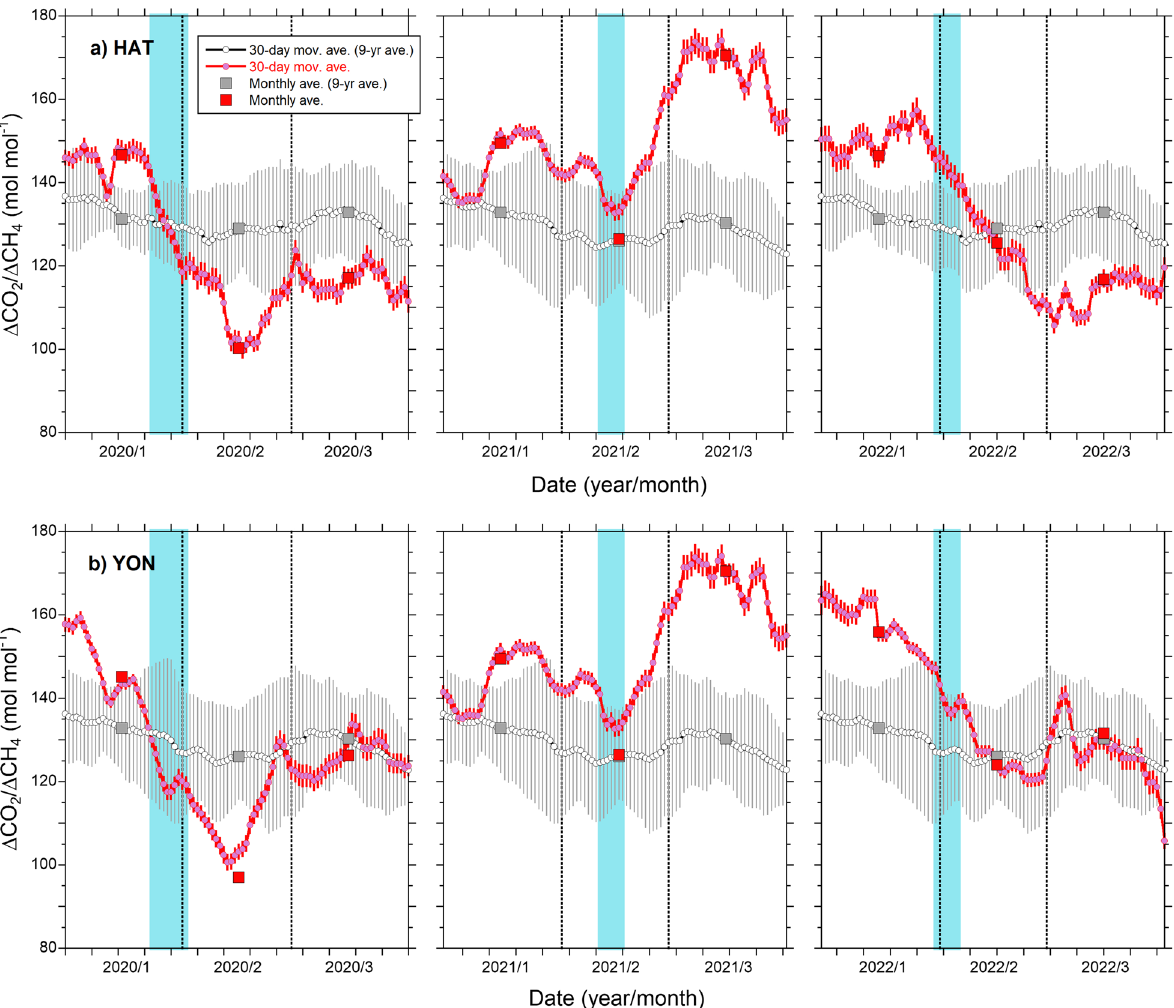
Fig. 4 Consecutive changes in the ΔCO 2 /ΔCH 4 ratio during January–March 2020, 2021, and 2022. The changes based on the observations at ( a ) HAT and ( b ) YON are depicted. The pink dots with lines and the red squares represent the 30-day moving averages and the monthly averages of the ΔCO 2 /ΔCH 4 ratio, respectively. The gray open circles are the averages of the 30-day moving averages of the ΔCO 2 /ΔCH 4 ratio for the preceding 9 years (2011–2019) and the vertical bars are their uncertainties. The temporal resolution of the consecutive changes is light-blue-shaded areas correspond to the Chinese New Year